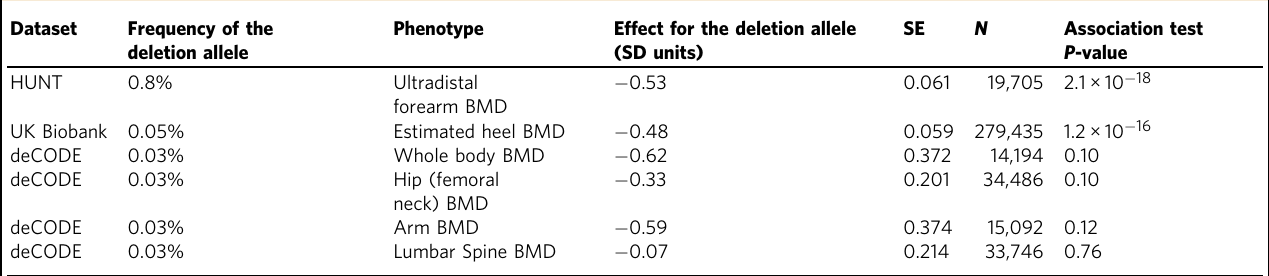
Table 2 Association of the MEPE LoF variant to BMD phenotypes in the three study datasets.